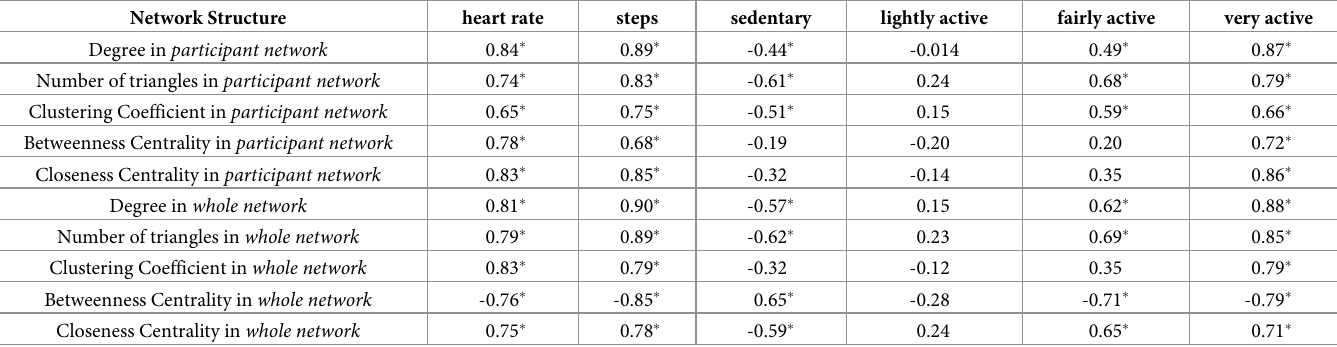
Table 5 summarizes the fraction of participants with medium to strong correlations with respect to health behavior features and at least one graph structure feature from participant network , whole network or both networks, respectively. Particularly, the percentages are the fraction of persons whose health behavior data has no less than 0.5 cross correlation Table 3. Normalized cross correlation coefficients of each pair of health behavior feature averages and social network structure feature averages. Network